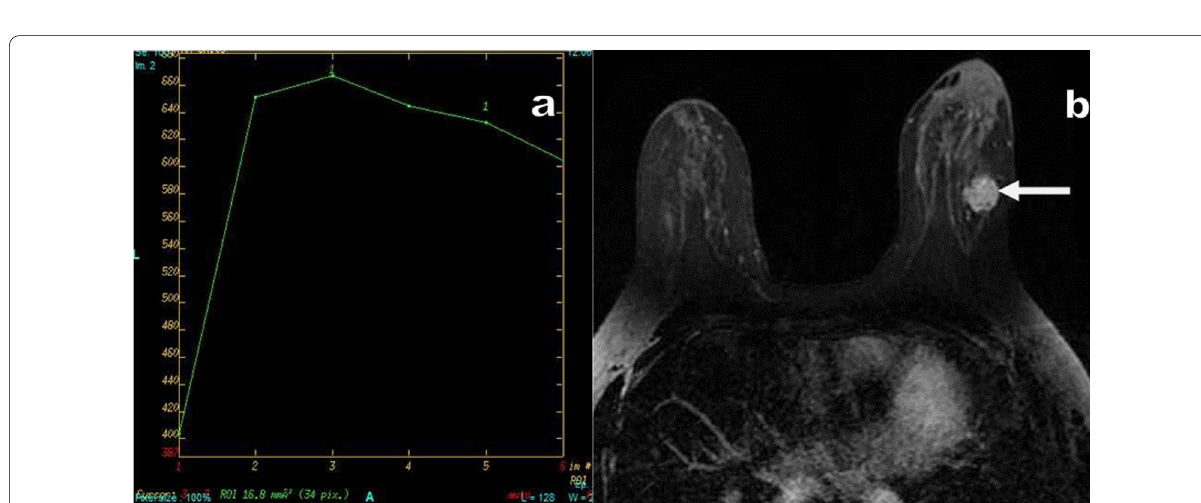
Fig. 5 MRI depicting. a Type III kinetic curve. b MRI showing increase in size of solid enhancement